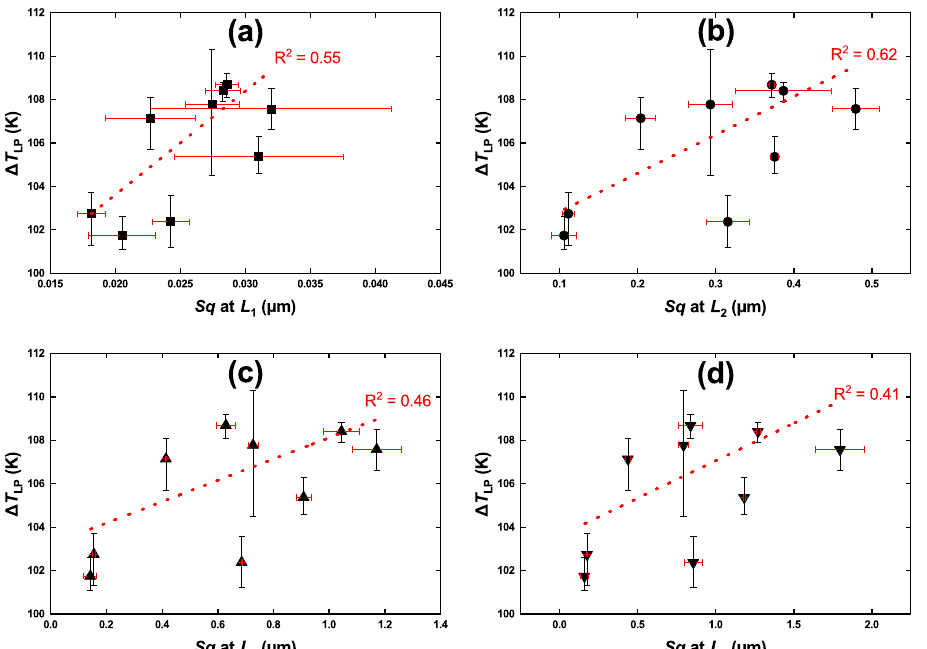
Figure 9. The relationships between ∆ T LP and Sq at various spatial scales: ( a ) L 1 = 3.9 µ m, ( b ) L 2 = 18.8 µ m, ( c ) L 3 = 96.9 µ m, ( d ) L 4 = 491.4 µ m. Straight lines were used for fitting, and the correlation coefficient R 2 of each fitting line was